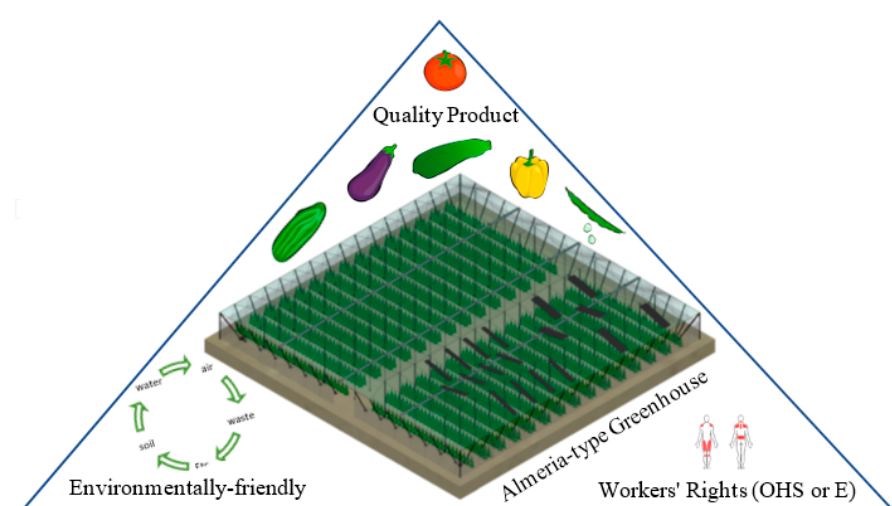
Figure 1. Sustainable agriculture in an Almeria-type greenhouse (southeast of Spain).